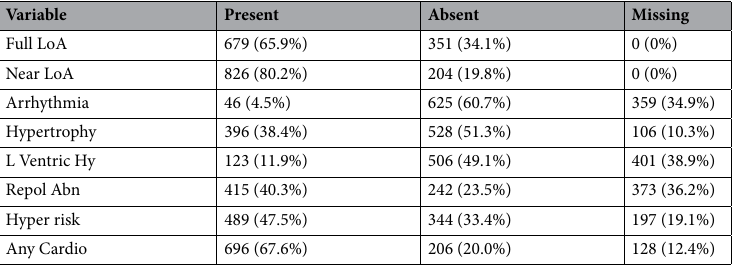
Table 1. Distribution of categorical targets in the training set. The table shows presence, absence and missing data of categorical features in the training set, illustrating eventual class imbalances. LoA loss of ambulation; L Ventric Hy left ventricular hypertrophy; Repol Abn repolarisation abnormalities; Hyper Risk engineered variable coding the likelihood of the presence of cardiac